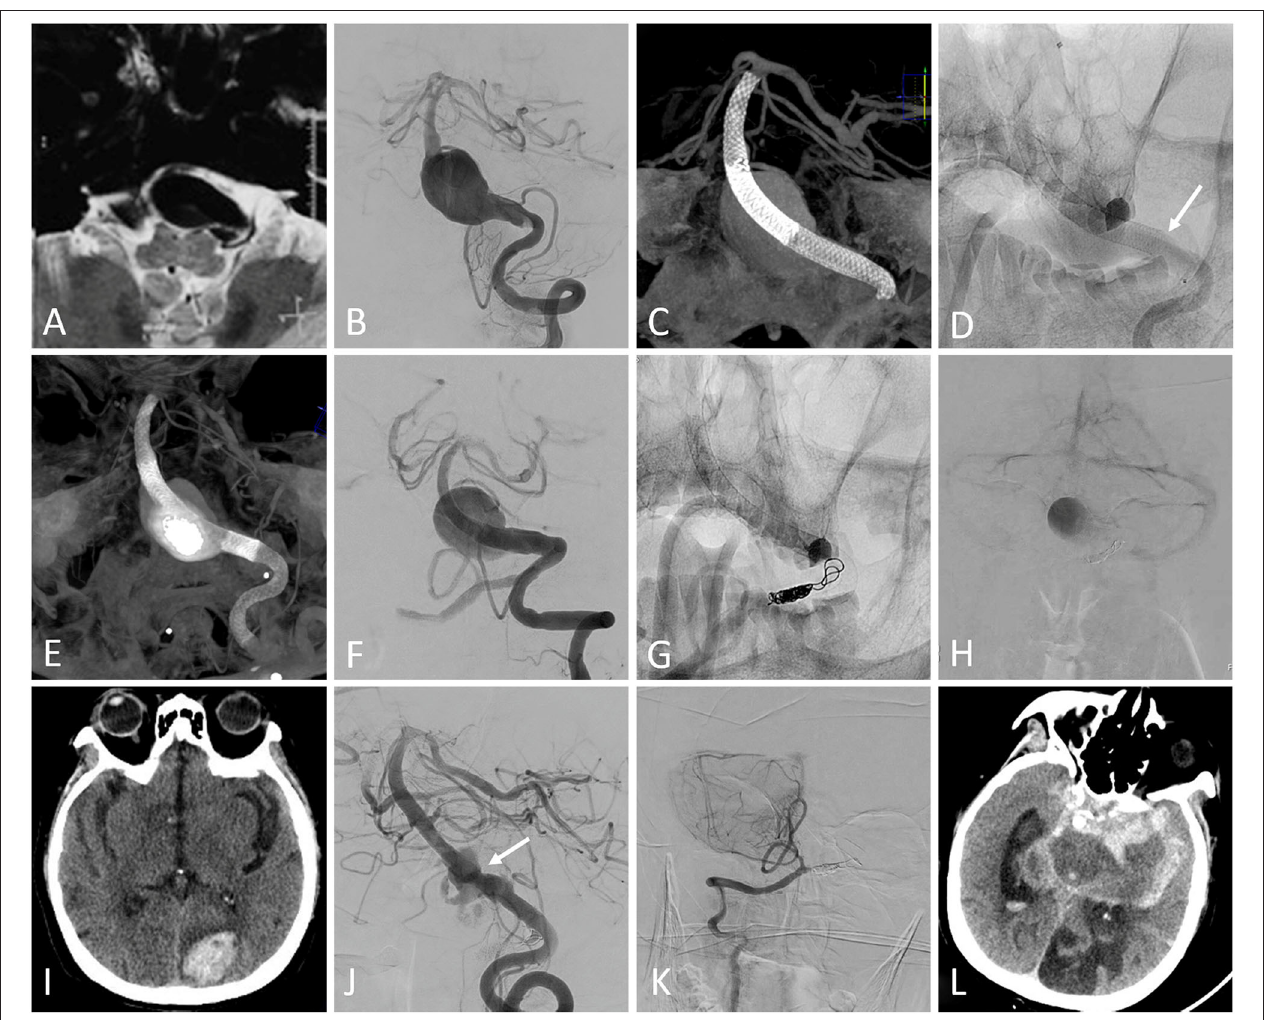
FIGURE 1 | (A) MRI showed a large lesion extending from the medulla oblongata to the pons. (B) Pretreatment digital subtraction angiography (DSA) demonstrated a basilar artery aneurysm. (C) Two overlapping Pipeline embolization devices (PEDs) were deployed without adjunctive coiling. (D) The second PED shortened after the complete deployment (the arrow showed the proximal end of the second PED). (E) A third PED was deployed. (F) The DSA showed the patency of the parent artery. (G) The contralateral vertebral artery was occluded using coils and the blood flow detained to the venous phase was detected on postprocedural DSA (H) . The patient experienced right-sided motor weakness on the day after the procedure and the following CT did not show any hemorrhage. The motor weakness temporarily resolved after the administration of tirofiban and low-molecular weight heparin, but the left occipital lobe intraparenchymal hemorrhage was detected on CT 2 weeks after the procedure (I) . The patient experienced left-sided motor weakness 18 months after the procedure and the follow-up DSA showed the partial residual of the aneurysm, with mild in-stent stenosis (arrow) (J) . The right posterior inferior cerebellar artery remained patency (K) . The aneurysm ruptured 2 days after the angiography (L) and the patient finally